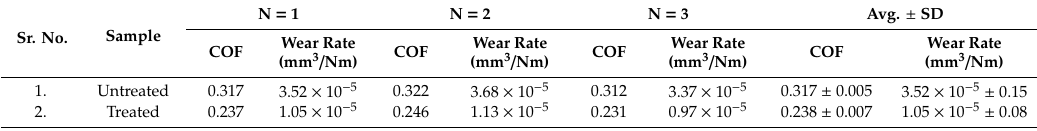
Table 6. Wear rate and co-e ffi cient of friction (COF) of samples. Sr.